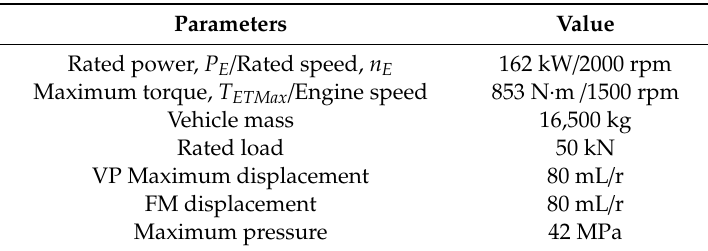
Table 3. The parameters of a wheel